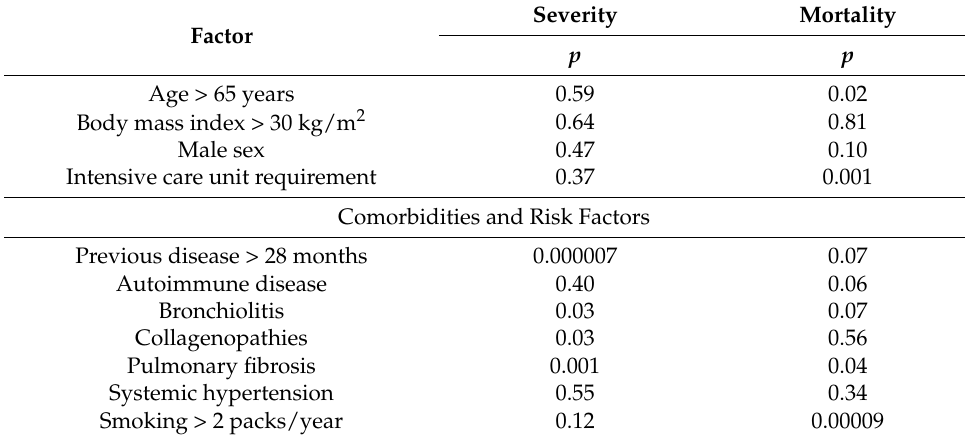
Table 2. Univariate severity- and mortality-associated factors based on the Kruskal–Wallis